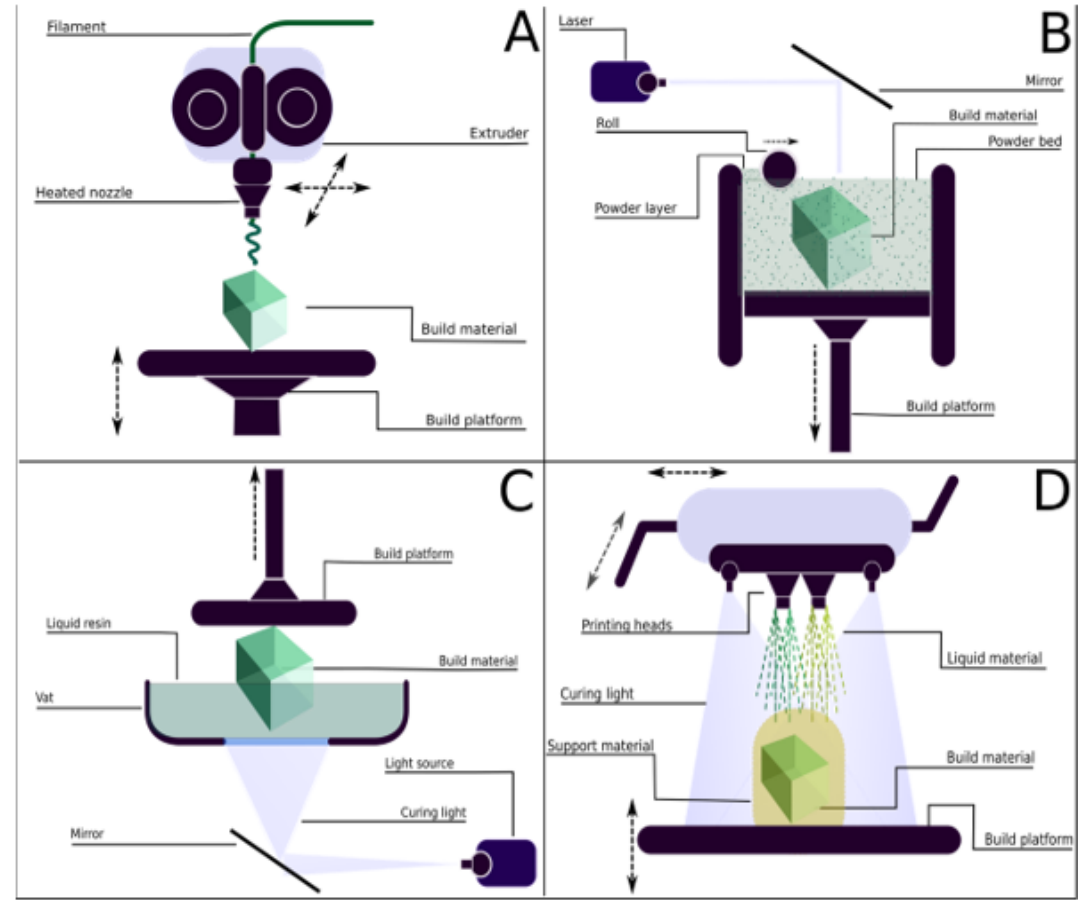
Figure 3. Three-dimensional printing techniques suitable for working with polymers. ( A ) Material extrusion. ( B ) Powder bed fusion. ( C ) Vat photopolymerization. ( D ) Material jetting.